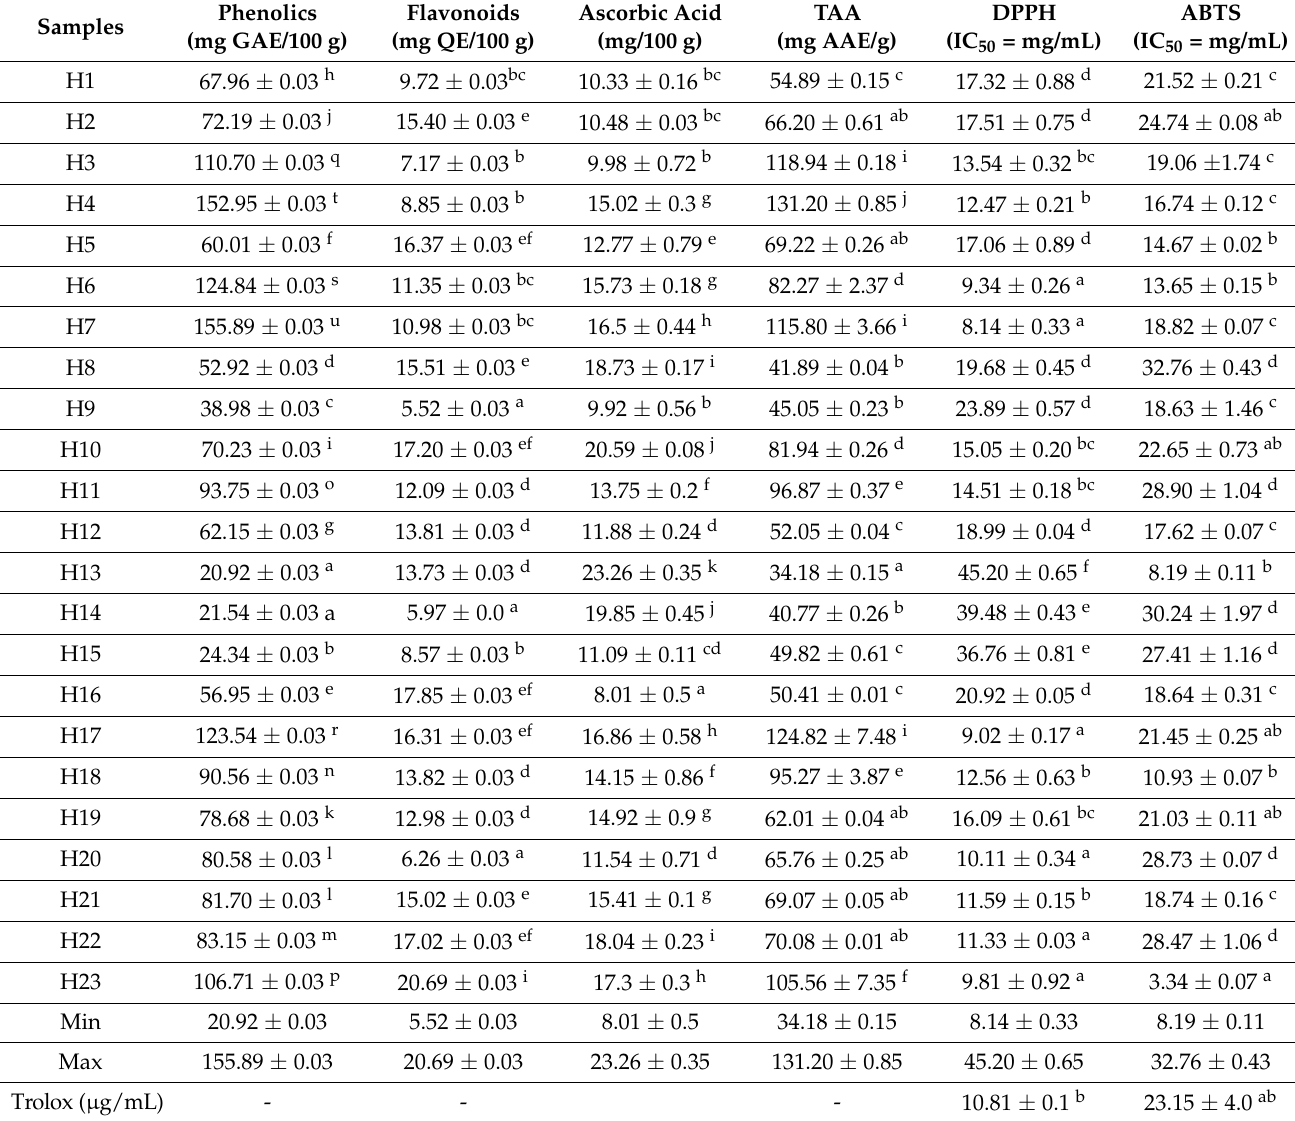
Table 4. Phytochemical constituents and antioxidant activities of honey